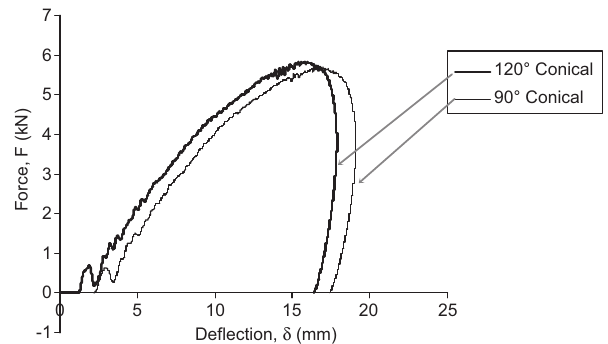
Figure 7 Force-defl ection curves for the conical